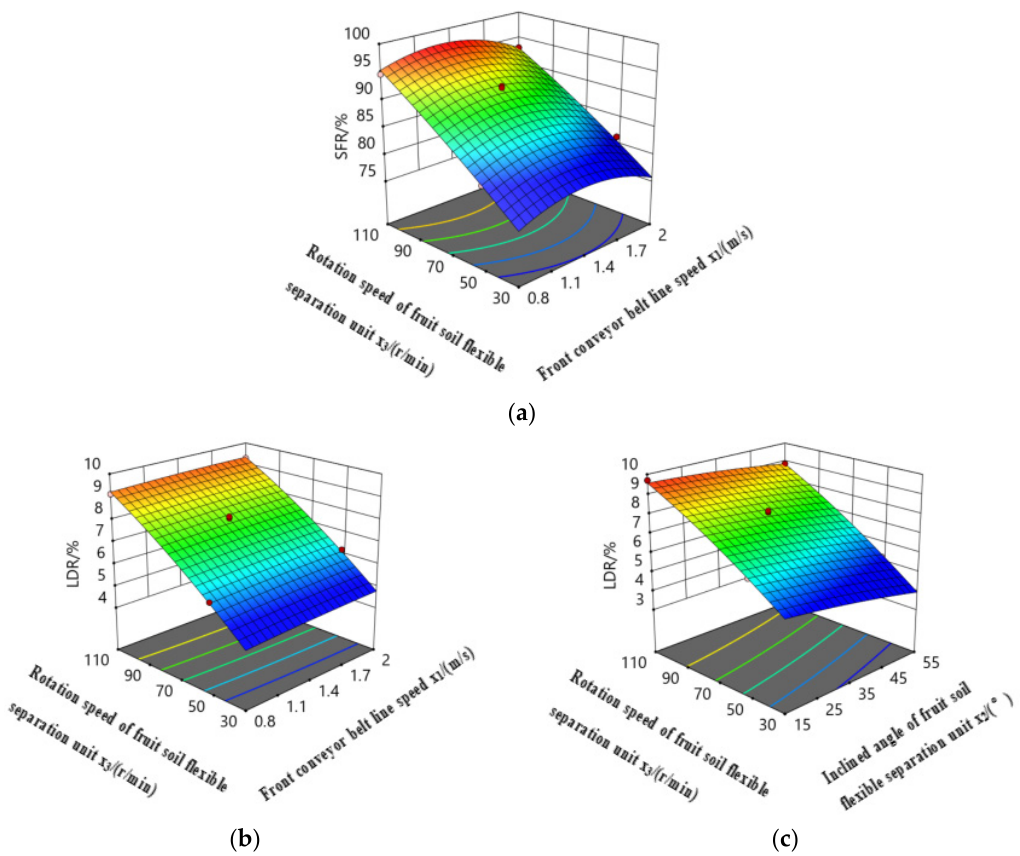
Figure 7. Response surfaces of interactive factors influencing test indexes. ( a ) SFR = f(x 1, 0, x 3 ); ( b ) LDR = f(x 1 , 0, x 3 ); ( c ) LDR = f(0, x 2 , x 3 ).